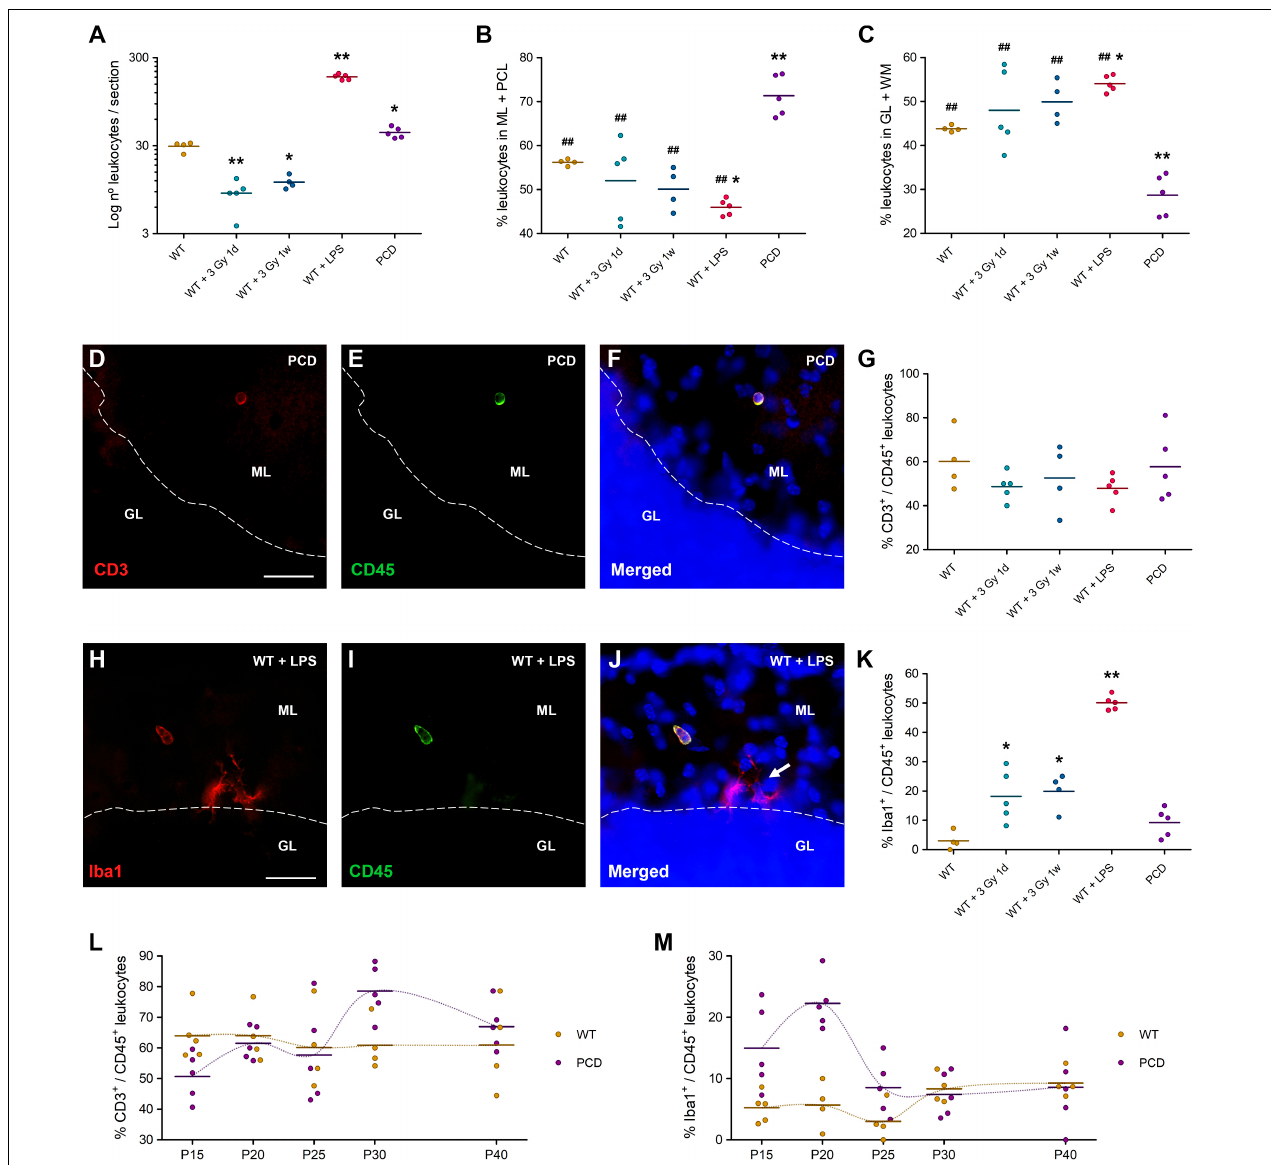
FIGURE 3 | Leukocyte characterization in the cerebellum of different animal models of neuroinflammation. (A) Quantification of the number of leukocytes per section of cerebellar vermis. In this case a logarithmic scale was used to achieve a better visualization of the data, since the number of leukocytes in LPS-treated mice was much higher than in the other groups. (B,C) Distribution of leukocytes in ML + PCL (B) and GL + WM (C) ; these results are complementary. Note the remarkable differential distribution of leukocytes in PCD mice. (D–F) Immunolabeling for CD3 (red) and CD45 (green) of a T cell in the molecular layer of a PCD mouse. (G) Percentage of T cells in the cerebellum. (H–J) Immunolabeling for Iba1 (red) and CD45 (green) of a monocyte in the molecular layer of a LPS-treated mouse. Arrow: microglial cells, which were negatively marked with CD45. (K) Percentage of monocytes in the cerebellum; note that radiation-induced or LPS-induced inflammation triggered monocyte infiltration, which was extremely low in both WT and PCD mice. (L,M) Temporal analysis of the percentage of T cells (L) and monocytes (M) in the cerebellum of WT and PCD mice; the crossing between temporal lines (dotted lines joining the mean values of each age) in both charts is indicative of the interaction between the factors analyzed. Note the fluctuations over time in PCD animals, while WT mice showed a relatively constant percentage of both T cells and monocytes throughout the whole period studied. Data are expressed as dot plots, where each dot represents one individual animal and horizontal lines represent the mean of each group. * p < 0.05 and ** p < 0.01, regarding WT mice; ## p < 0.01, regarding PCD mice. Scale bars: 25 µ